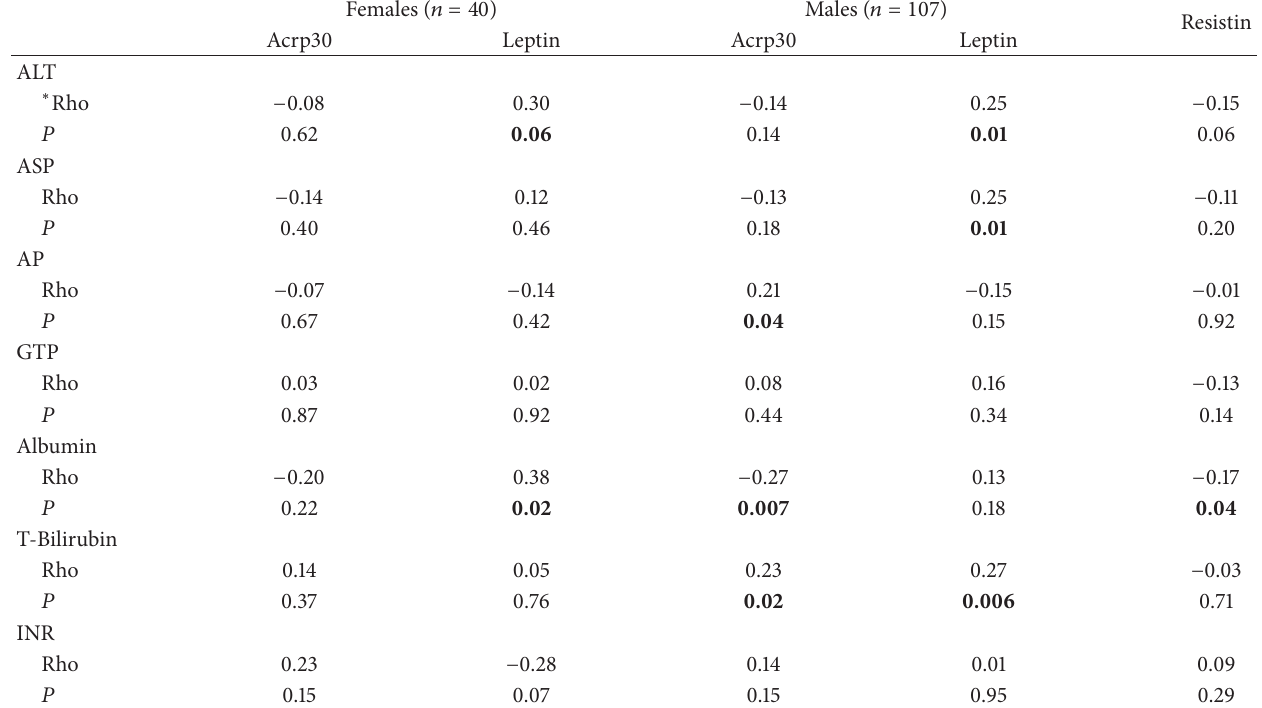
Table 8: Analysis of the correlation between serum adipokine levels and liver function parameters.